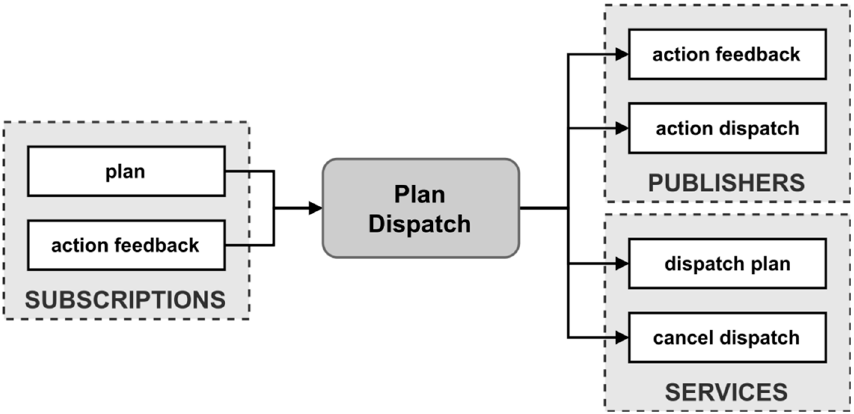
Figure 23. ROSPlan Plan Dispatch node.